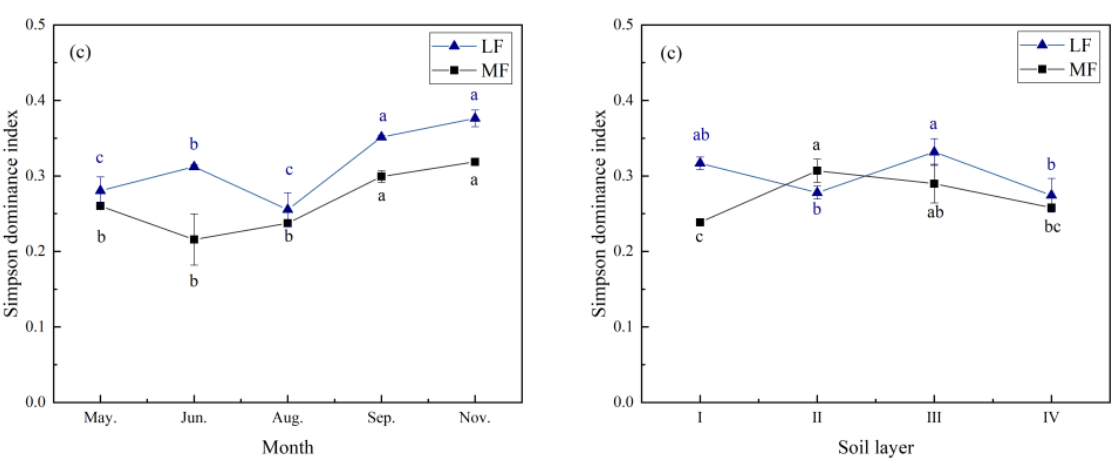
Figure 4. Temporal and vertical distribution of diversity indices of the soil fauna. ( a ) The Shannon– Wiener index ( H ); ( b ) the Pielou evenness index ( J ); ( c ) the Simpson dominance index ( C ).